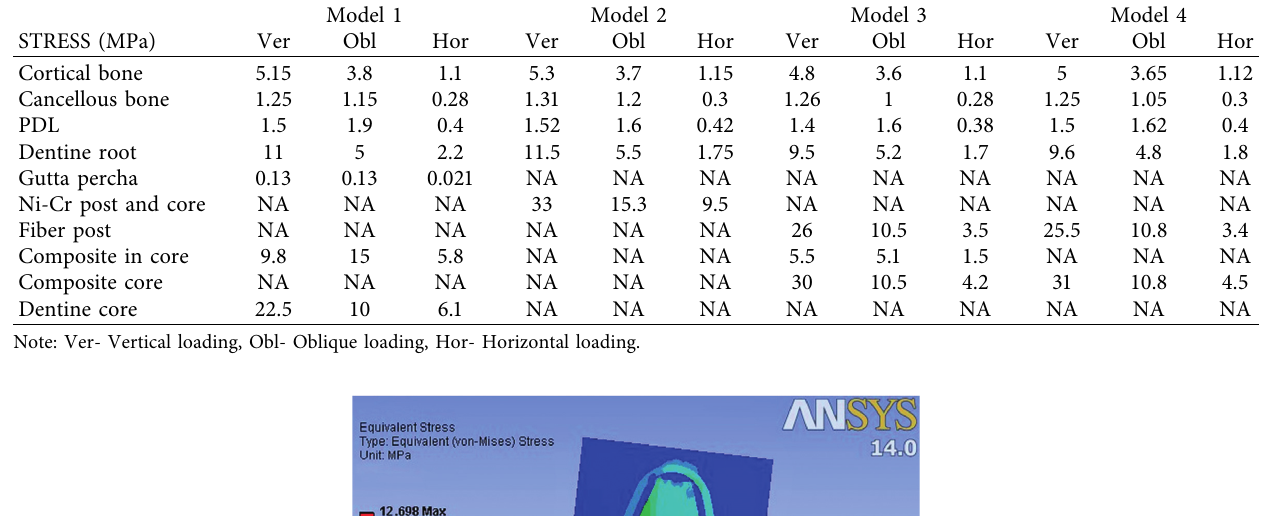
Table 5: Stress distribution pattern in finite element models.